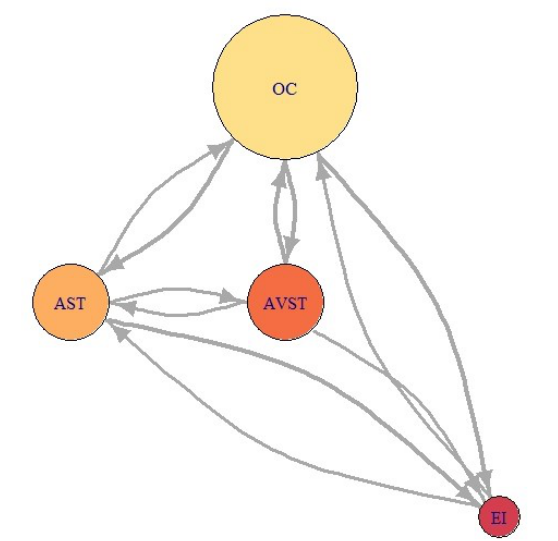
Figure 6. Sample of static network visualization of AOI transition matrix from Table 2.